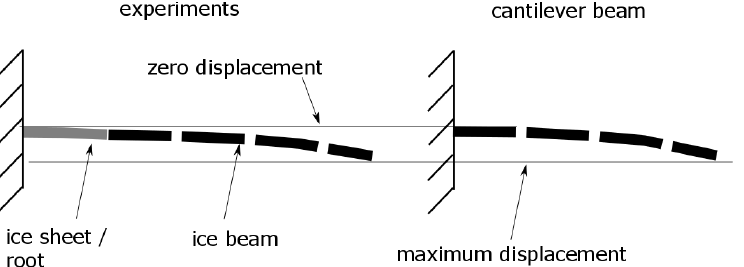
Figure 4. Force-displacement signal of a flexural strength measurement with MIVET model ice (S2000). The slope S1 marks the initial linear deformation behavior and S3 the representative average linear deformation behavior.